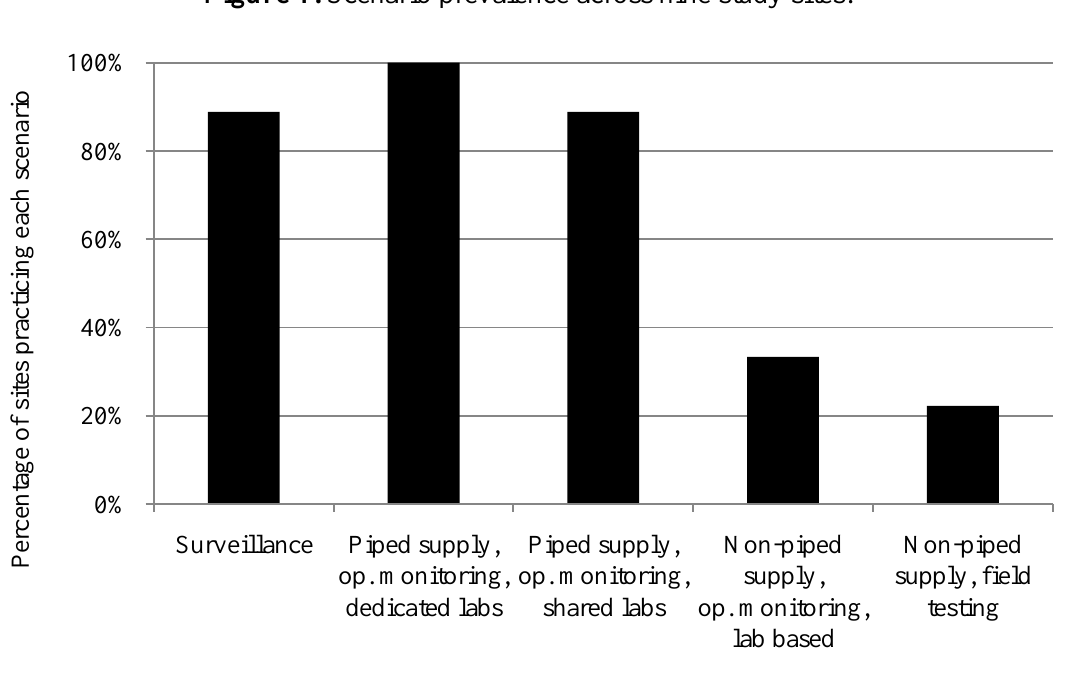
Figure 1. Scenario prevalence across nine study